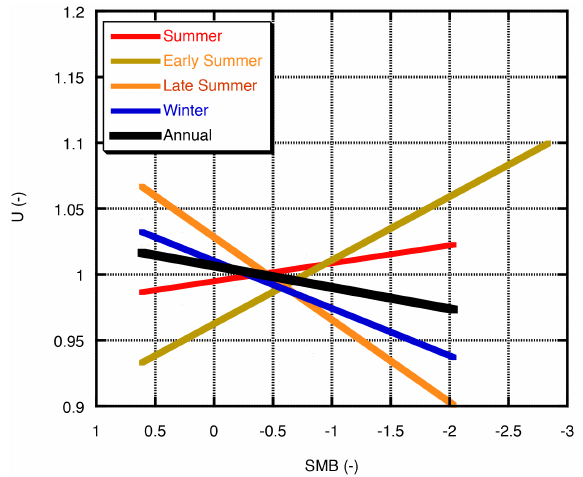
Figure 7. Relation between velocity and surface mass balance (SMB) for different seasons averaged over the upper ablation area (S6–S9). SMB data of different years are normalized with the mean over the period 1990–2010 and divided by the standard deviation. Velocity data are normalized with their mean over the correspond- ing season and then averaged. Data for velocity and mass balance refer to the period 2005–2012. All fits are statistically significant (minimum r = 0 . 79; maximum r = 0 . 96, n = minimum 5 years; n = maximum 7